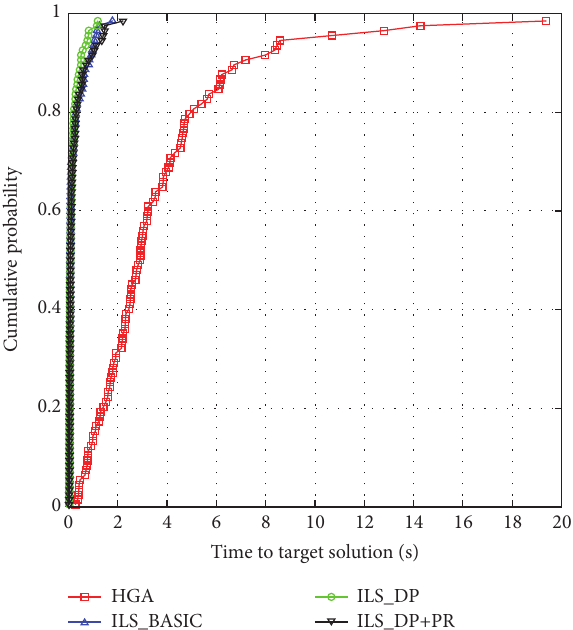
Figure 7: TTT plots of HGA, ILS BASIC, ILS DP, and ILS